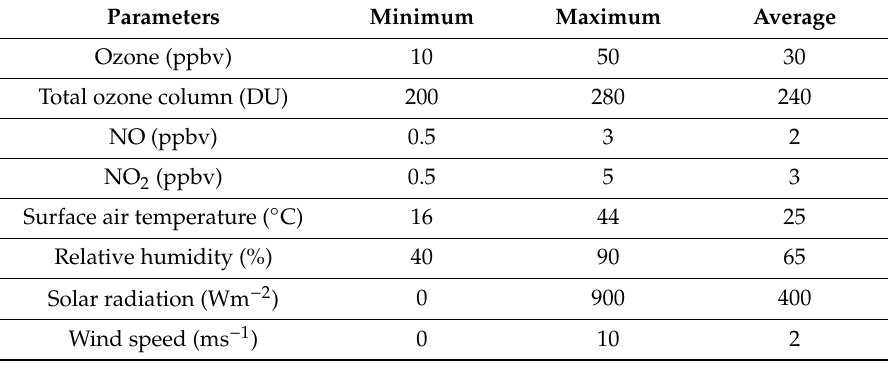
Table 2. Input parameters used for artificial neural network analysis.